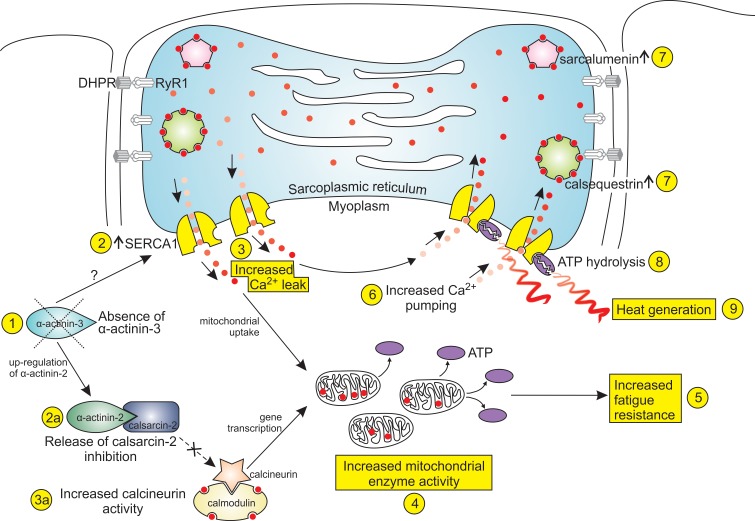
Cold acclimatisation and thermogenesis in α-actinin-3-deficient fibres.The diagram shows the mechanisms by which a loss of α-actinin-3 from fast glycolytic muscle fibres could promote adaptation to cold environments. The increased Ca2+ leak (3), increased mitochondrial enzyme activity (4) and increased fatigue resistance (5) are all features of muscle fibres from mice exposed to prolonged cold, and hence α-actinin-3 deficiency can be said to “pre-acclimatise” muscles to cold environments. In addition, the increased pumping by the SERCA1 Ca2+-ATPase consumes ATP and generates heat (9), providing a thermogenic mechanism which would also enhance cold survival.